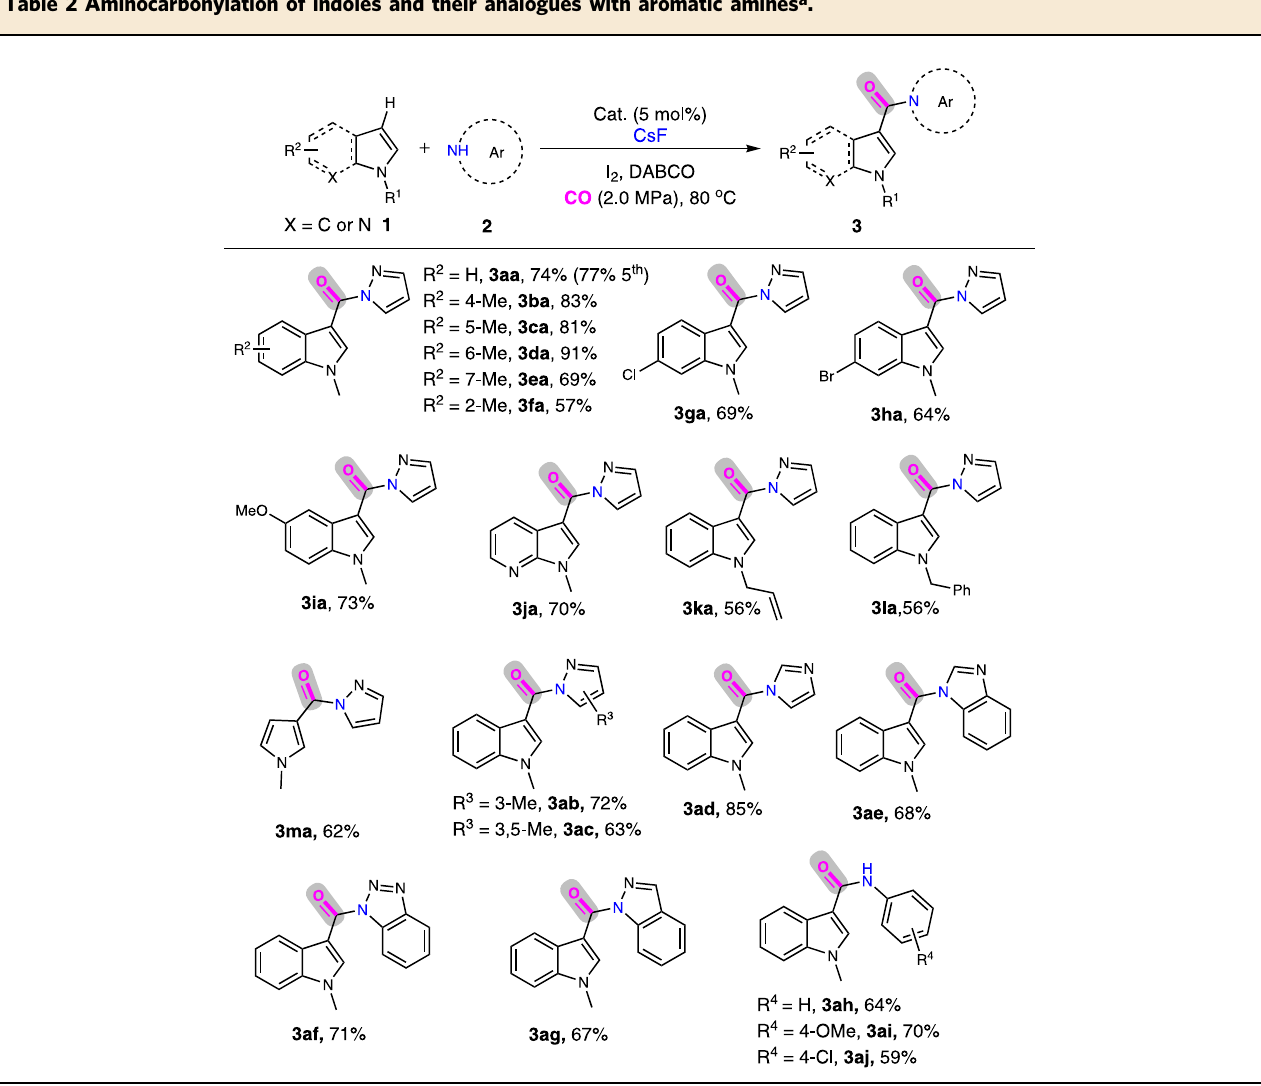
Table 2 Aminocarbonylation of indoles and their analogues with aromatic amines a